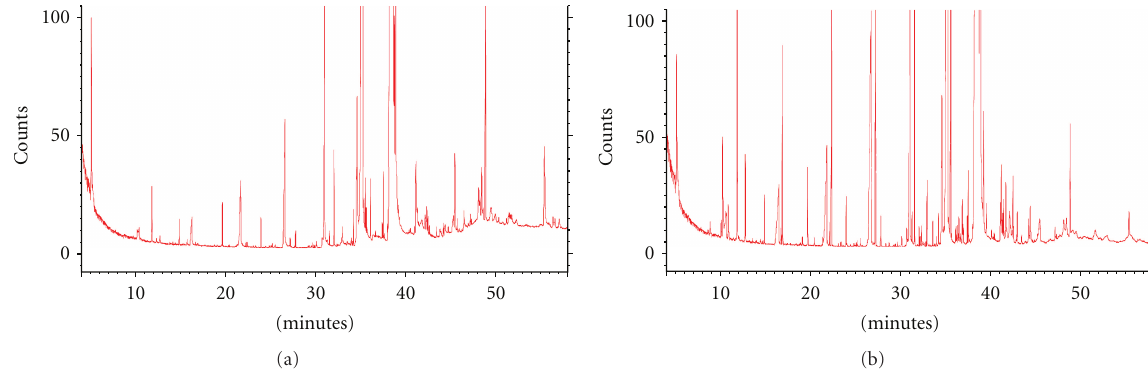
Figure 1: GC chromatograms of the non polar dissolved organic matter extracted in n-hexane from composts C1 (a) and C4 (b). Some of the classes of the functional groups are reported here as a function of the retention time (minutes): up to 32 (cid:6) we have terpene, decanoic, dodecanoic, and tetradecanoic acids, and tetradecenal. The remaining peaks were attributed to C16–C18 fatty acids and relative esters. At 50 (cid:6) squalene was found. It can be seen that the region at low retention times in chromatogram (b) is more crowded than in (a).